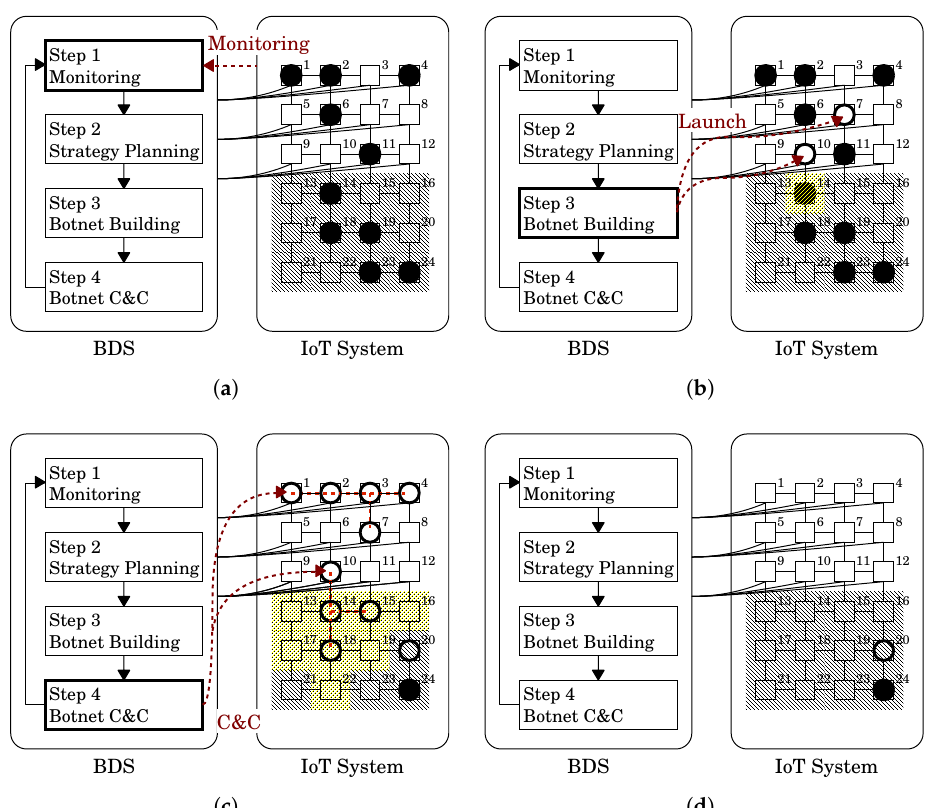
Figure 4. A state transition of the BDS for the IoT system with restricted observability and controllability. ( a ) State when the BDS detected a malicious botnet. The unobservable and uncontrollable nodes are shaded. The BDS could check only the observable nodes and found only 5 out of 10 bots; ( b ) State in botnet building of Step 3. The BDS sent two white-hat worms to the controllable nodes, n 7 and n 10 and built the initial white-hat botnet. Each white-hat bot can observe and control adjacent nodes instead of the BDS; ( c ) State in which the white-hat botnet spread to even the unobservable and uncontrollable nodes and almost disinfected the malicious botnet. The BDS can indirectly observe and control the nodes shaded in yellow patterns through the message links (- - -) over the botnet. In Step 4, the BDS commanded self-destruction to the botnet; ( d ) State after the white-hat bots receiving the command self-destroyed. The command reached the white-hat bots not only at controllable nodes n 1 , n 2 , n 3 , n 4 , n 7 , n 10 but also at uncontrollable nodes n 14 , n 15 and n 18 linked with the bot at n 10 . Two bots